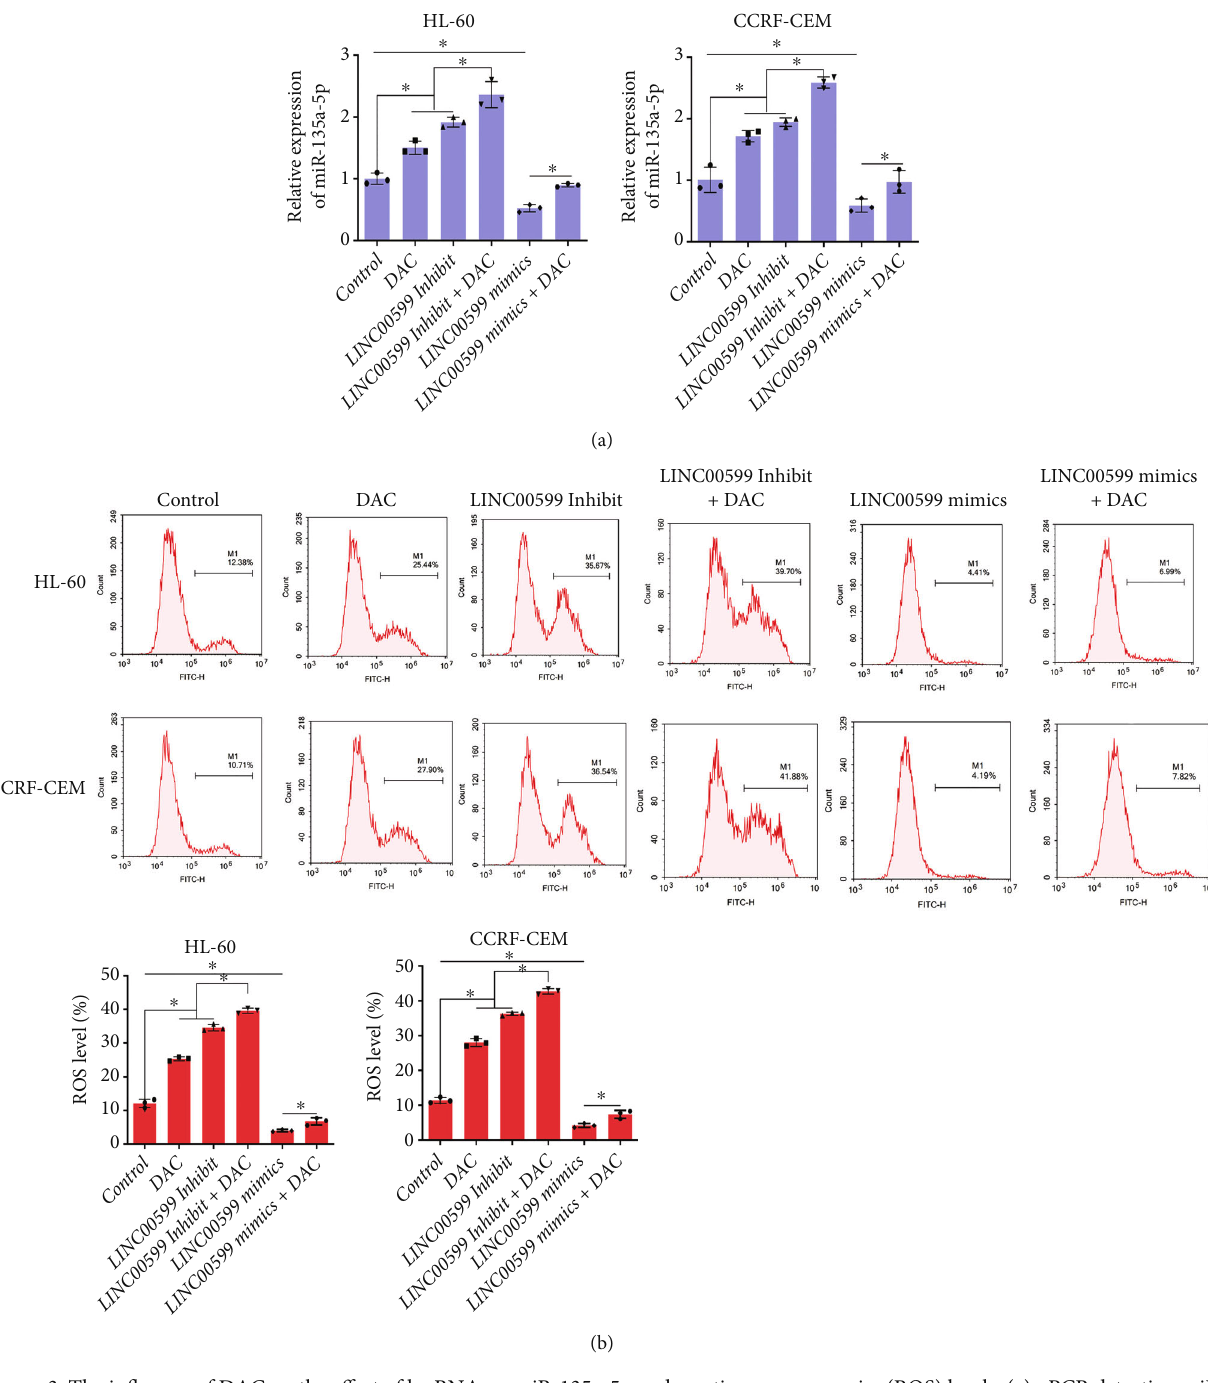
Figure 3: The in fl uence of DAC on the e ff ect of lncRNA on miR-135a-5p and reactive oxygen species (ROS) levels. (a) qPCR detecting miR- 135a-5p expression in cells and (b) results of fl ow cytometry analysis detecting ROS levels in each group of